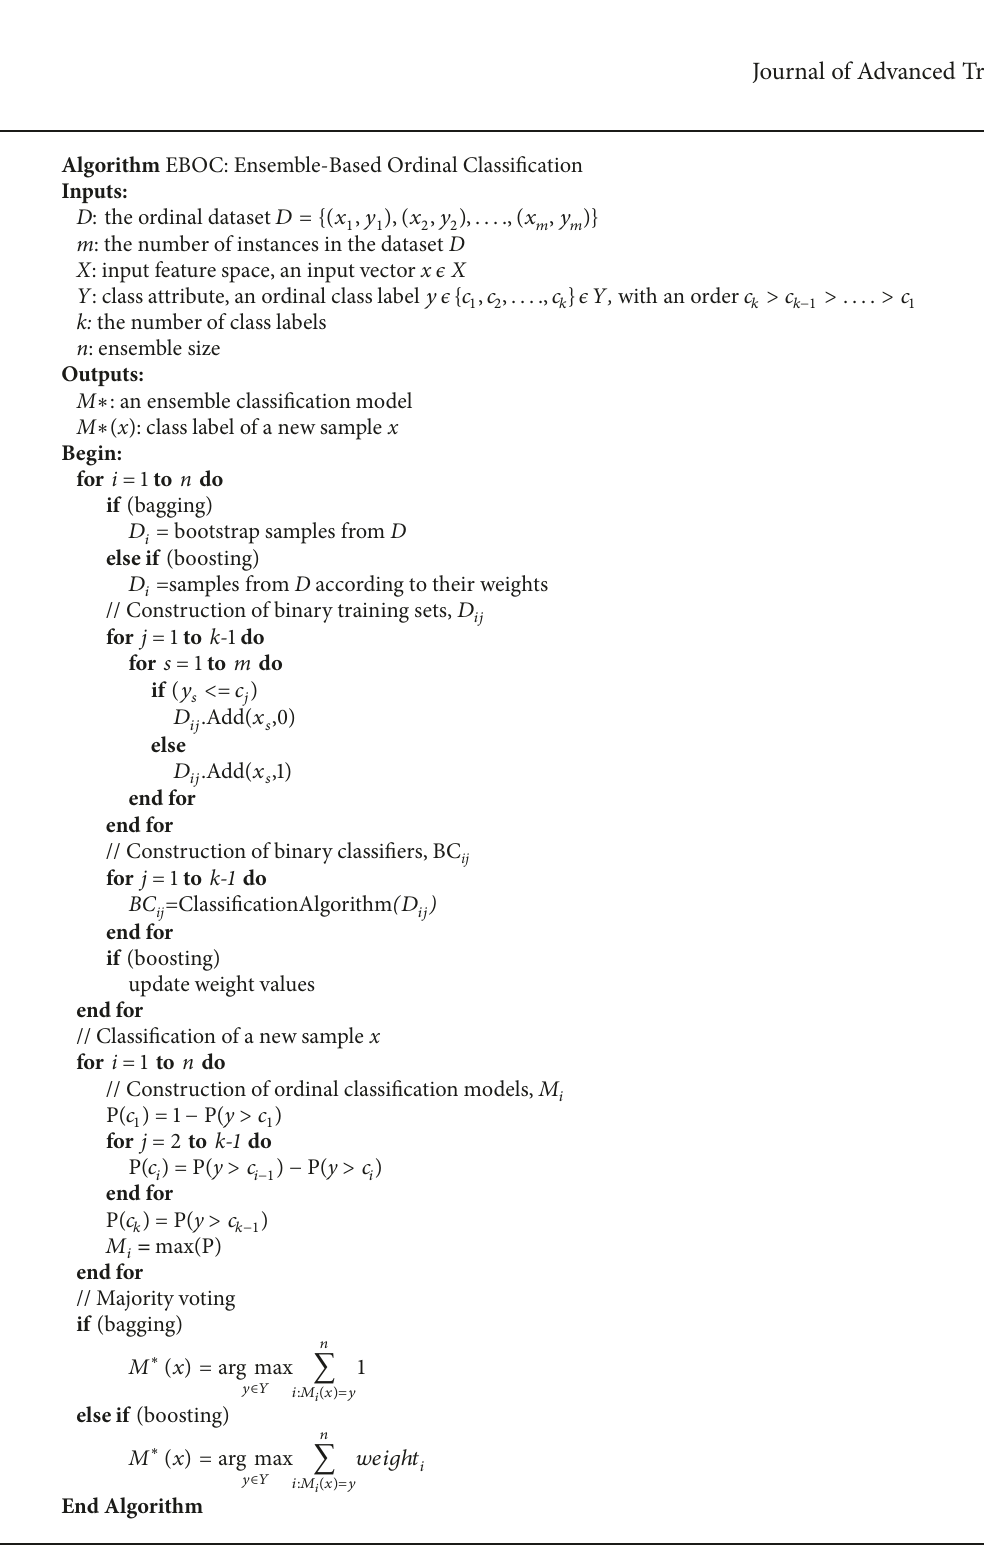
Algorithm 1: The pseudocode of the proposed EBOC